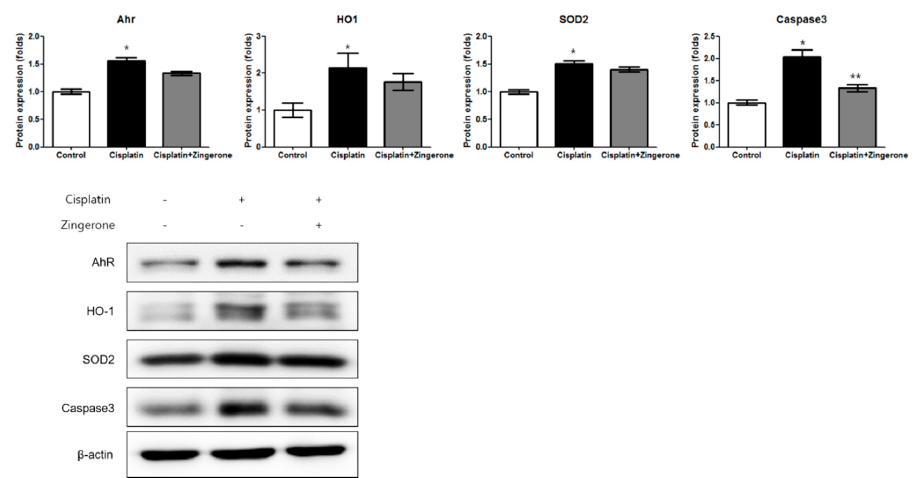
Figure 3. The protein expression levels of the aryl hydrocarbon receptor (AhR), heme oxygenase 1 (HO1), superoxide dismutase 2 (SOD2), and caspase 3 were higher in the cisplatin group than in the control group (* p < 0.05, ANOVA with Tukey’s post hoc test, control vs. cisplatin groups; ** p < 0.05, ANOVA with Tukey’s post hoc test, cisplatin vs. cisplatin + zingerone groups). The protein expression levels of caspase 3 were lower in the cisplatin + zingerone group than in the cisplatin group ( p = 0.03, ANOVA with Tukey’s posthoc test). The values shown in the graphs are the means ± standard deviations. (+: not administered, -: administered). Int. J. Mol. Sci. 2019 , 20 , x FOR PEER REVIEW